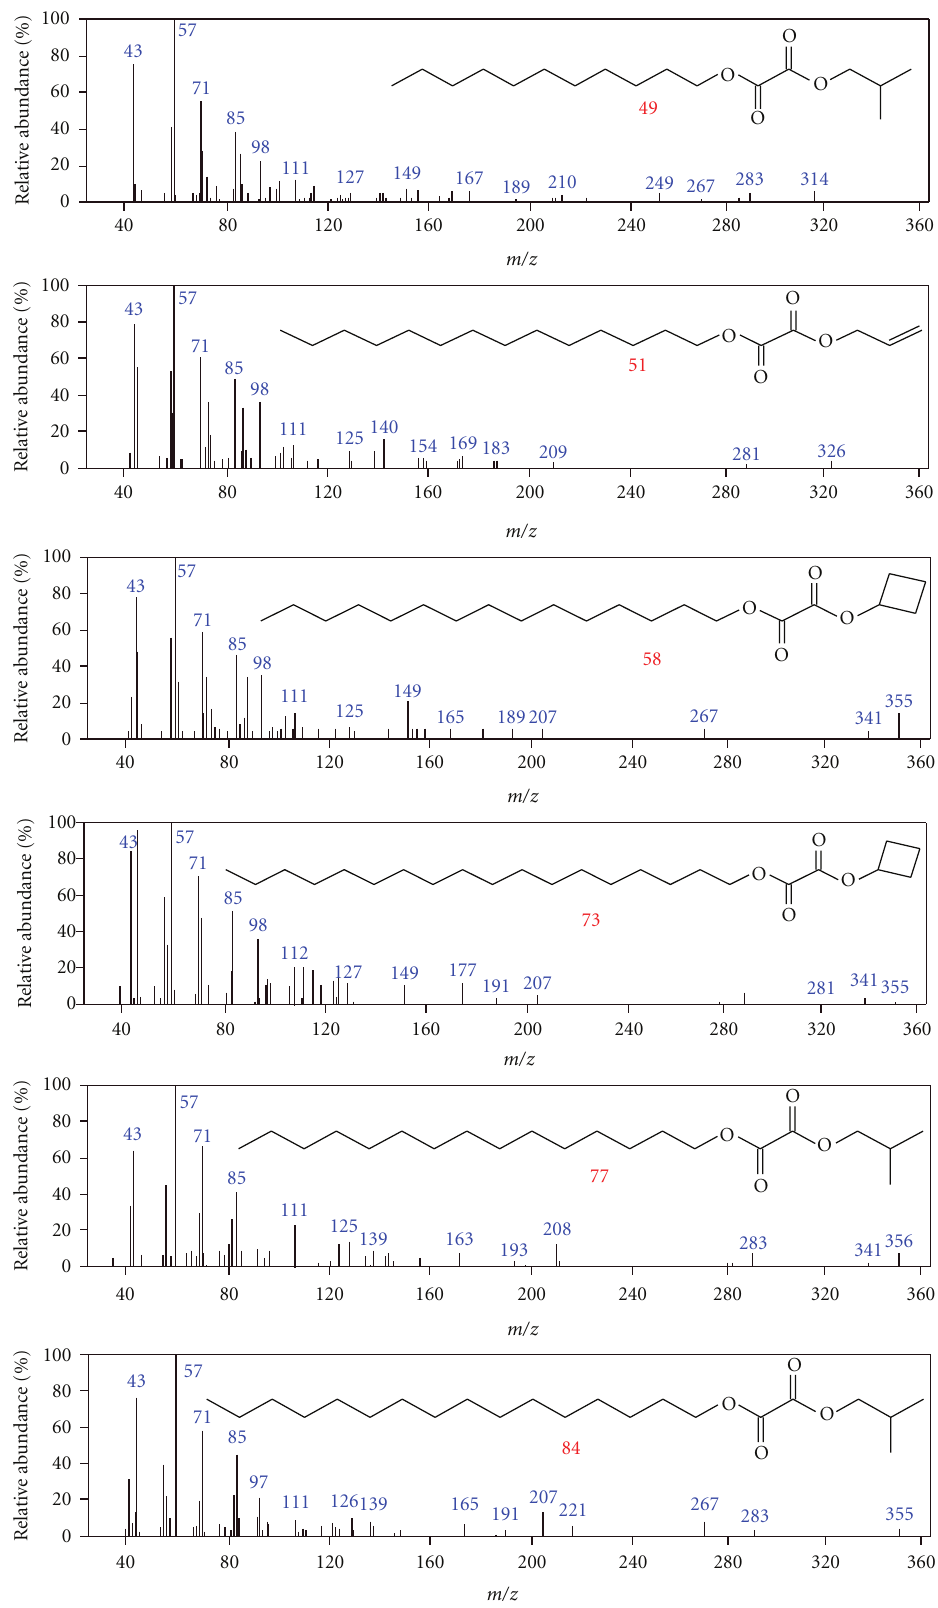
Figure 4: Mass spectra of the dialkyl oxalates detected in CSF ODVR